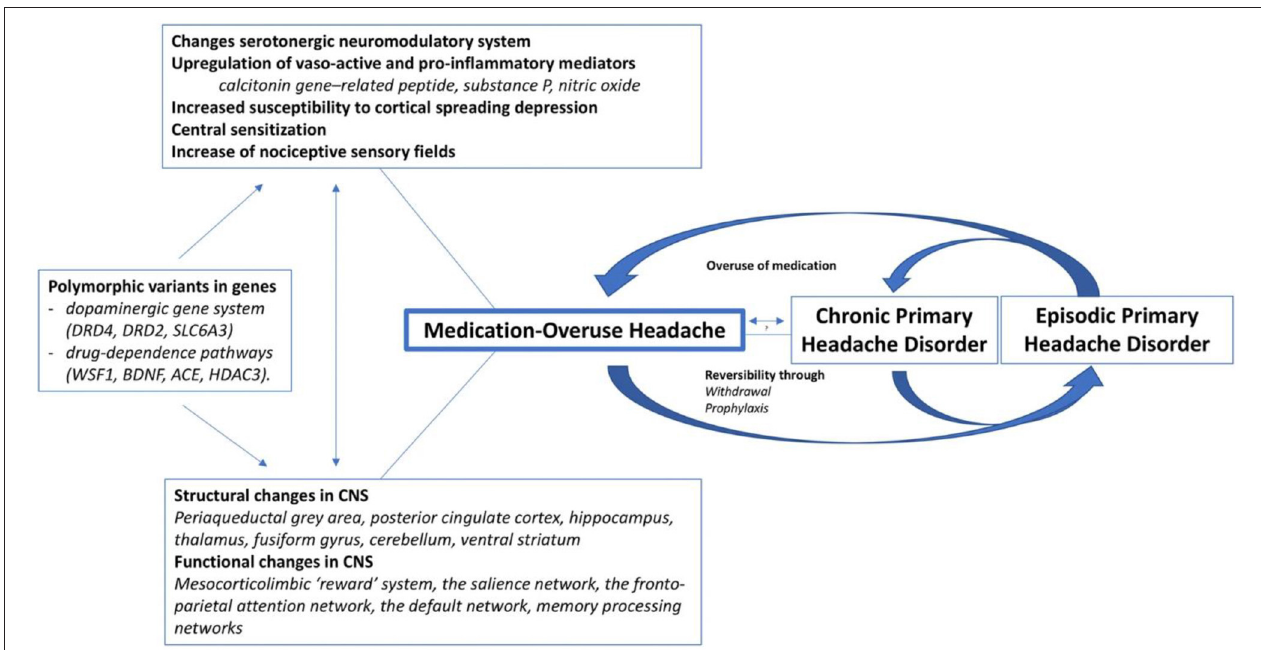
FIGURE 1 | Current understanding of the pathophysiology of medication-overuse headache [Vandenbussche et al. (11)]. CNS, central nervous system.